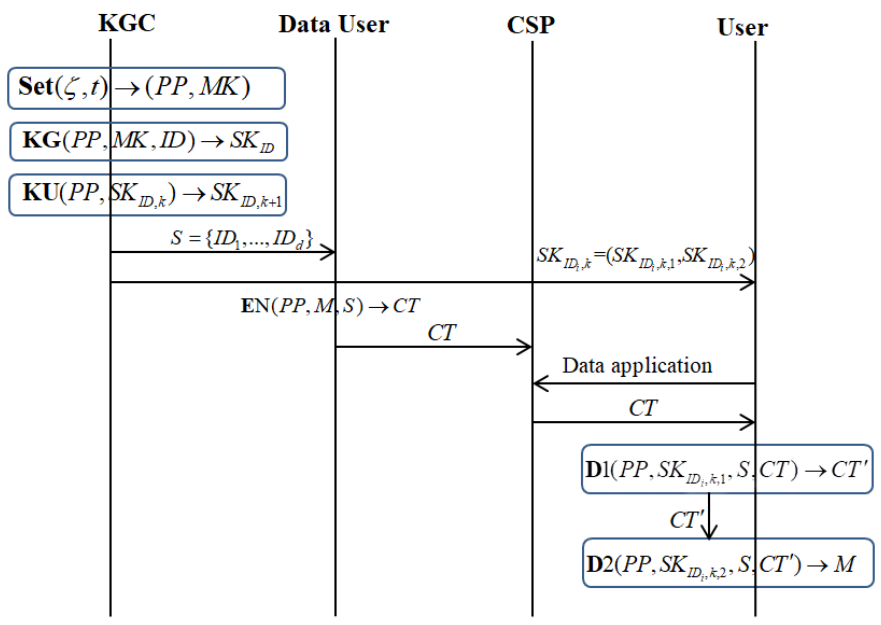
Figure 4. The relations of the algorithms of the proposed scheme.